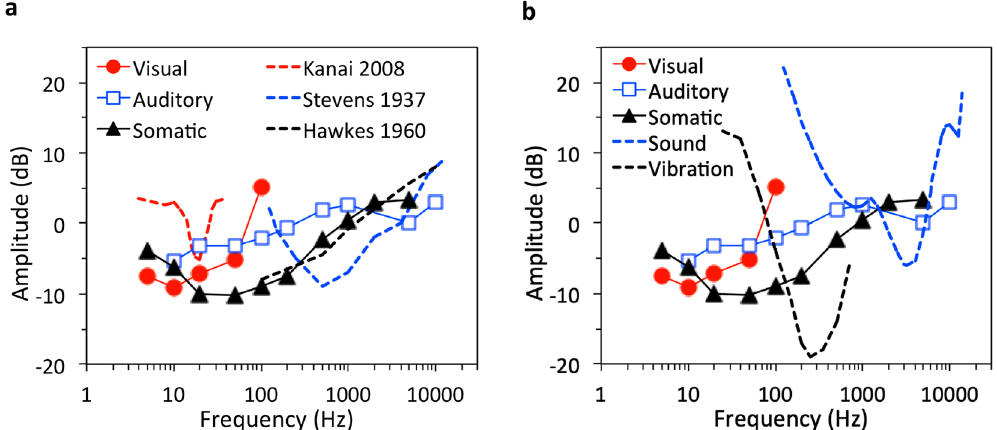
Figure 4. Electric and normal sensation thresholds ( a ) Comparison of the present result (symbols) with previous studies (dashed lines). The Kanai et al. study used two rubber electrodes with one being placed on the back of the head (inion, 3 × 4 cm) and another on the vertex (6 × 9 cm) 32 . The Stevens study used a copper wire immersed in saline solution that filled the ear canal and an aluminum disk strapped on the forearm 8 . The Hawkes study used a ring electrode on the finger and a round electrode on the palm 48 . All amplitude data were converted into dB referring to 1 mA except for electric hearing data from Stevens 1937, in which dB values were referred to 10 μ W. (b) Comparison with normal auditory sensation thresholds (dB RE: 20 μ Pa) evoked by sound 98 and normal tactile sensation thresholds evoked by vibration (dB RE: 1 μ m) 99